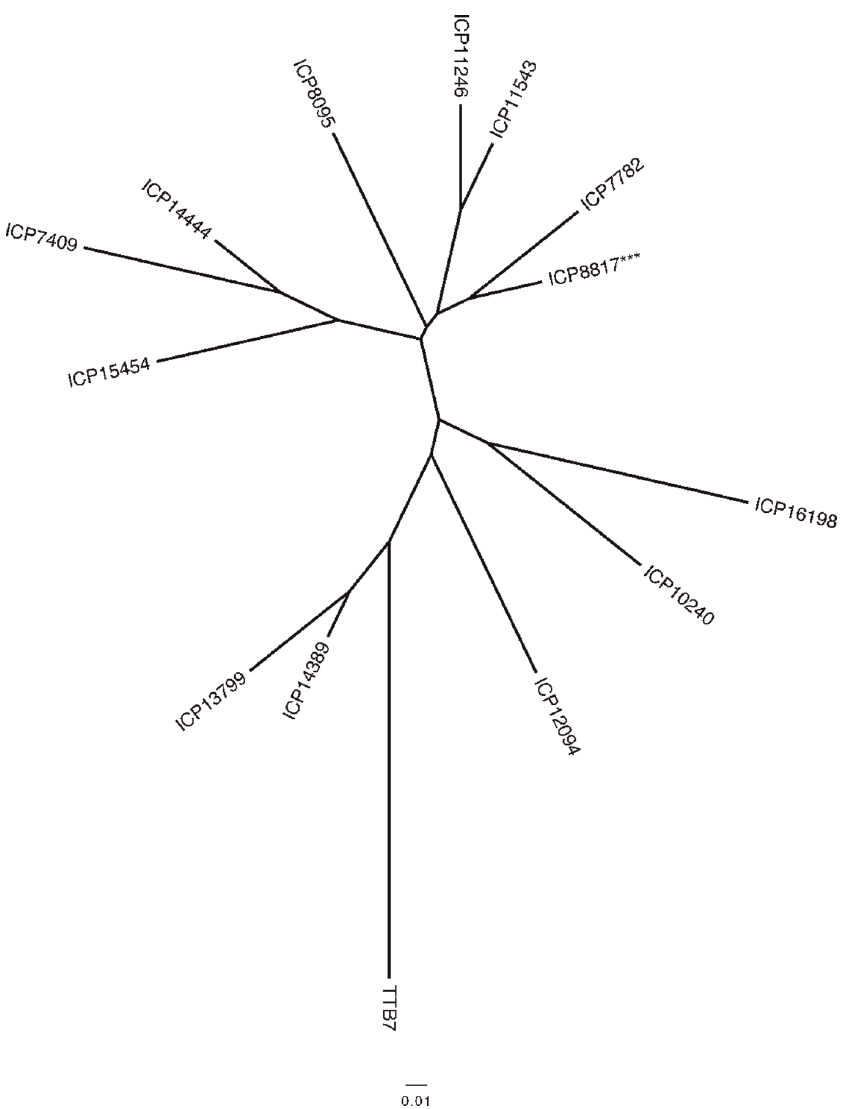
Figure 6. Inferred relationships among admixed Cajanuscajan accessions. An un-rooted Neighbor Joining tree depicting pairwise similarity between genotypes with simple admixture between domesticated-India and domesticated-tropical accessions. Admixed genotypes were identified based on mixed-group membership defined in Figure 5B. Accession ICP 8817 has an identical haplogype to accession ICP 9236, and thus only ICP 8817 is shown.